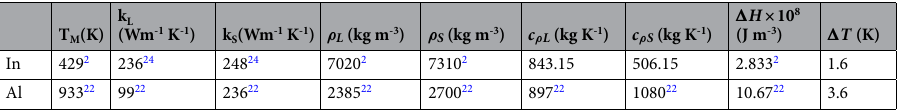
Table 1. Approximate physical parameter values for In and